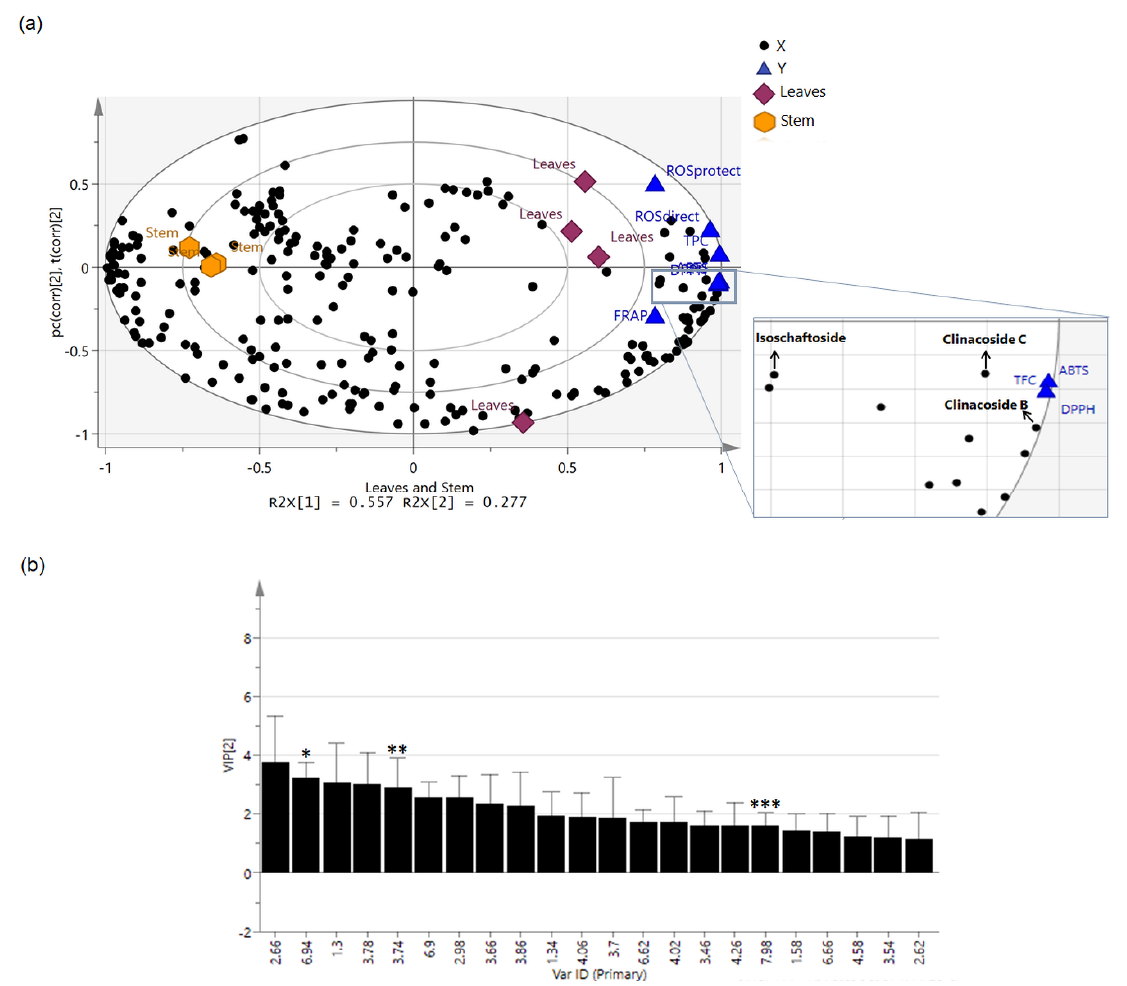
Figure 7. The partial least square (PLS) biplot ( a ) showing the correlation of the metabolites with chemical and cell-based assay results in CNL and CNS. Metabolites with variable importance in the projection (VIP) value ≥ 1.0 are labelled in black ( b ). The VIP metabolites with the respective symbols (*, Clinacoside B; **, Clinacoside C; ***, Isoschaftoside) are identified as metabolites contributing to the bioactivities.